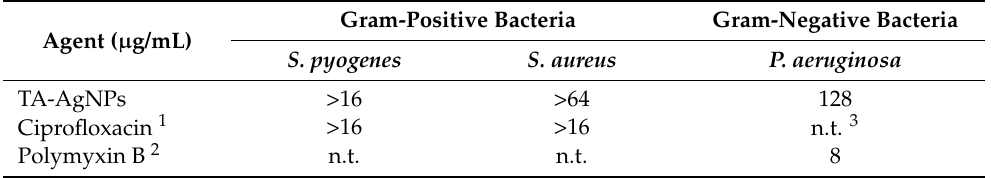
Figure 2. Effect of TA-AgNPs on the biofilm development at 595 nm: S. pyogenes ( a ); S. aureus ( b ); and P. aeruginosa ( c ). Inhibition effect of TA-AgNPs on the bacterial growth and biofilm formation of S. pyogenes ( d ); S. aureus ( e ); and P. aeruginosa ( f ). COL: collagen. **: p < 0.01, compared with control. Table 3. MBEC of TA-AgNPs against three wound